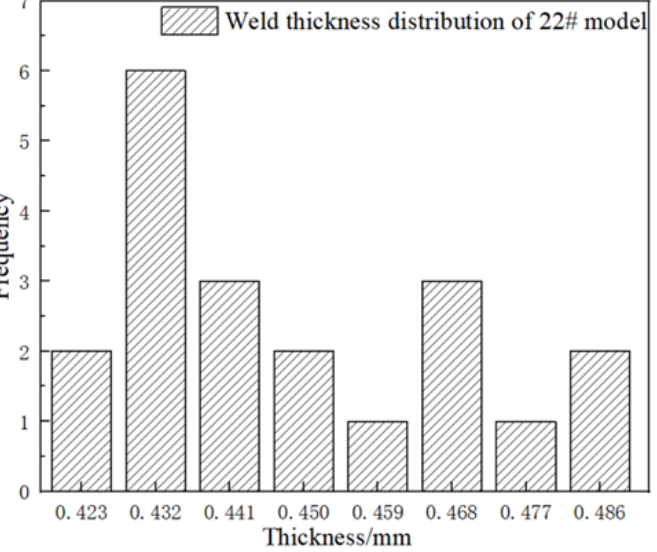
Figure 5. Thickness distribution of welding area.